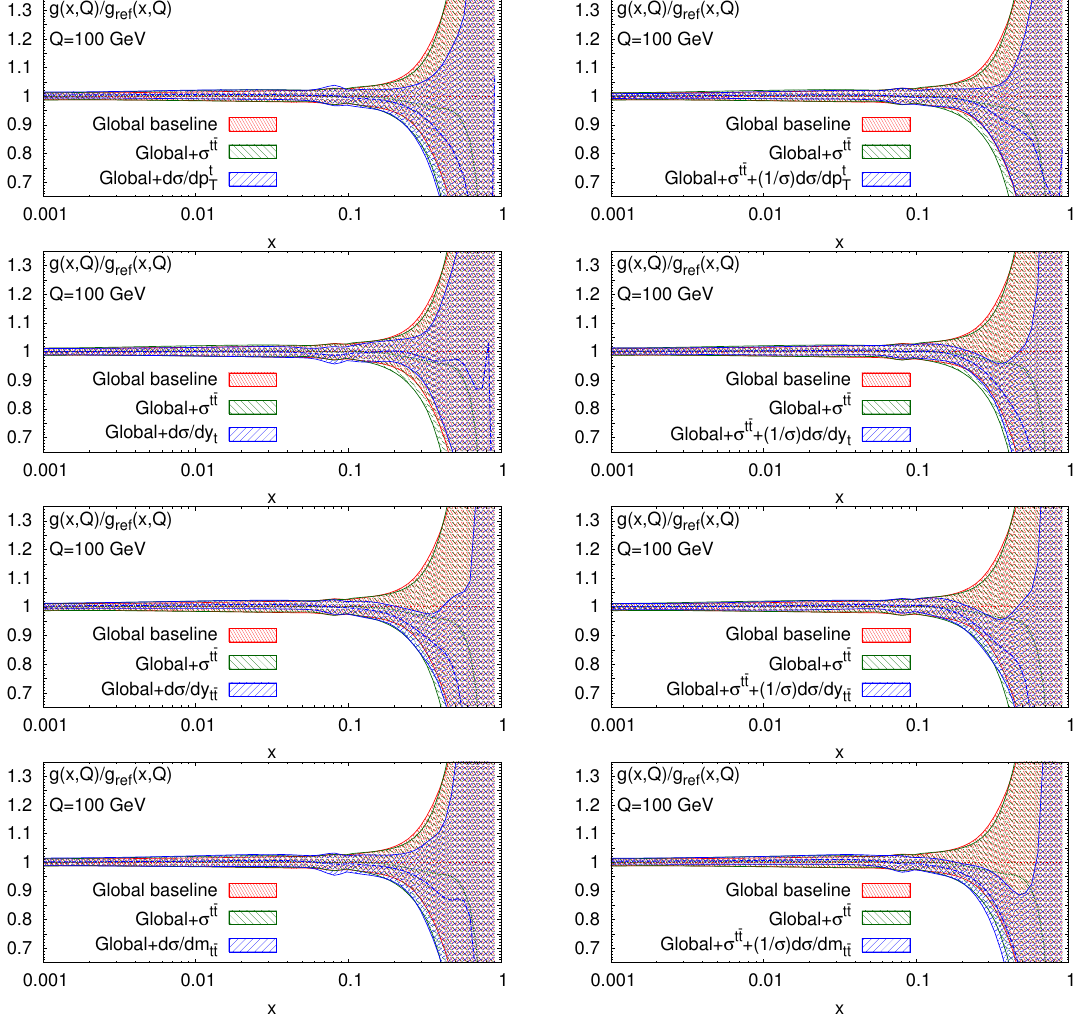
Figure 16 . Same as (cid:12)gure 14 for the global